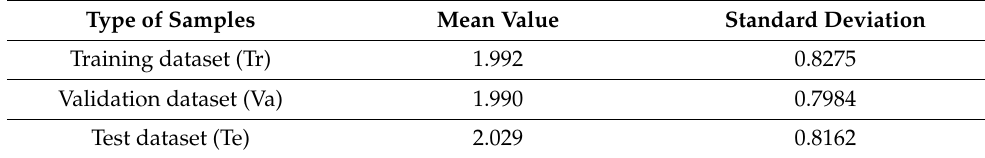
Table 3. The mean value and standard deviation of the three